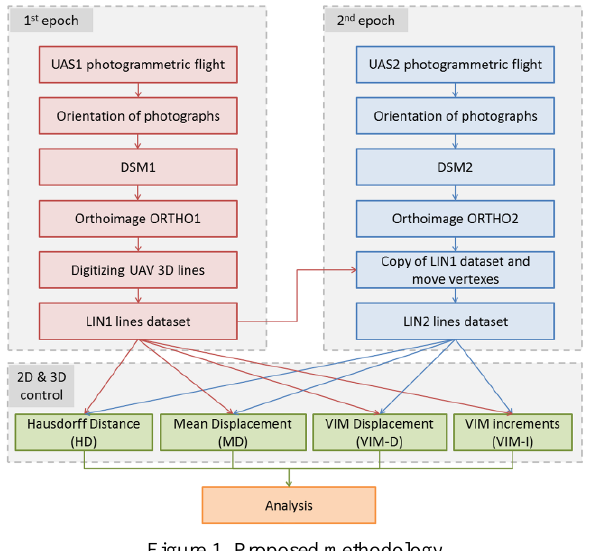
Figure 1. Proposed